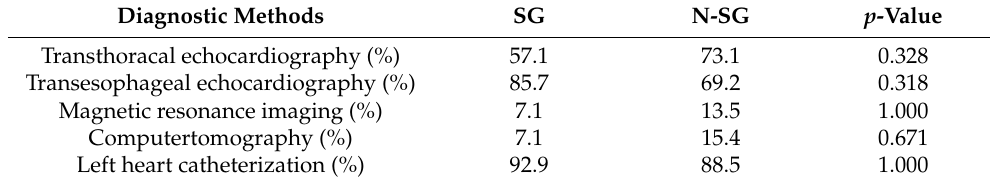
Table 3. Diagnostic methods.